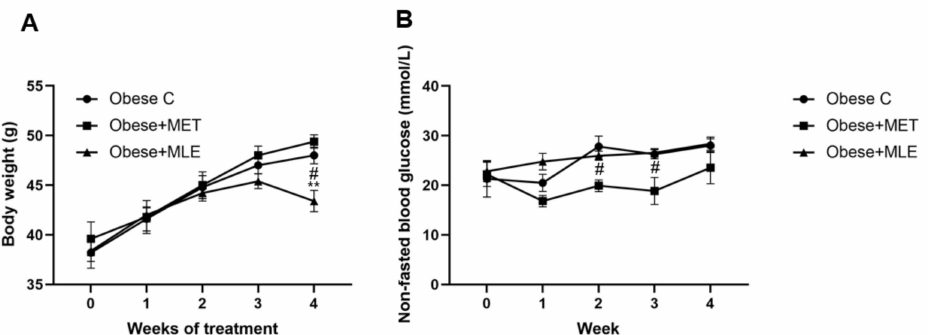
Figure 1. Bodyweight ( A ) and non-fasted blood glucose ( B ) results for db/db mice. Data are repre- sented as means ± SEM, with a sample size of 5 animals/group. GraphPad Prism 6 was used to test for statistical significance at a p -value ≤ 0.05.